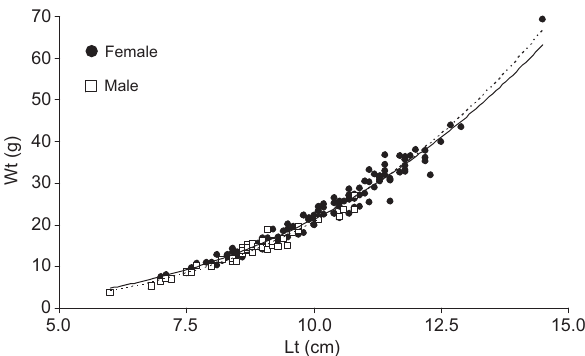
Figure 9. Weight-length relationship for A. lineatus females and males in the Paranaguá Bay, state of Paraná. The dashed line shows the slope of the straight line for males and the full line shows the slope of the straight line for females.